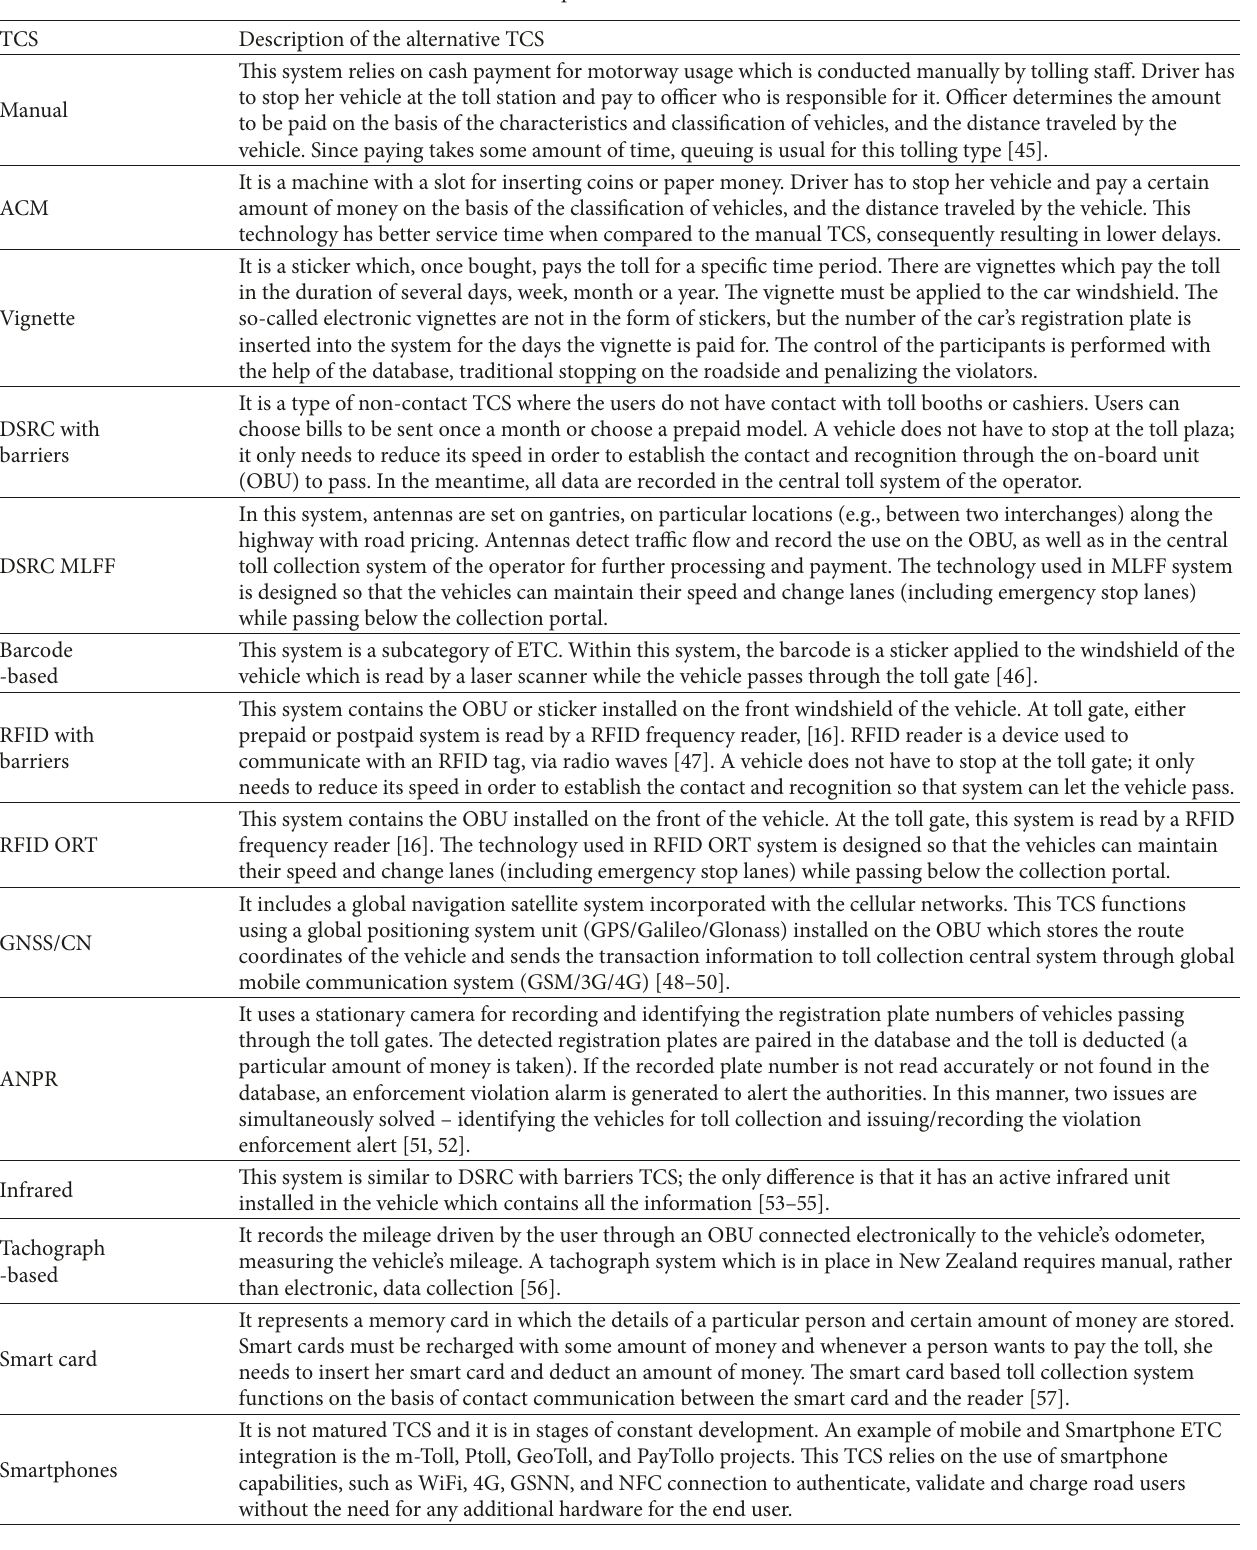
Table 2: Description of the alternative